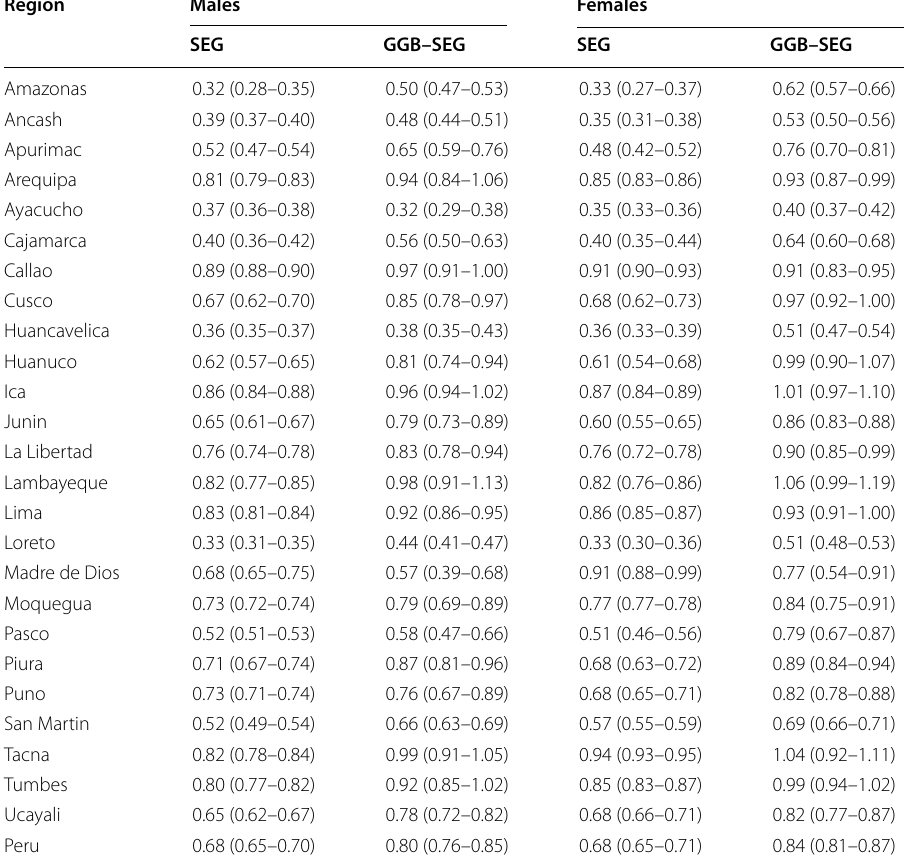
Format: [mean value (sensitivity analysis interval)]. Sources: Estimated from Ministry of Health data and